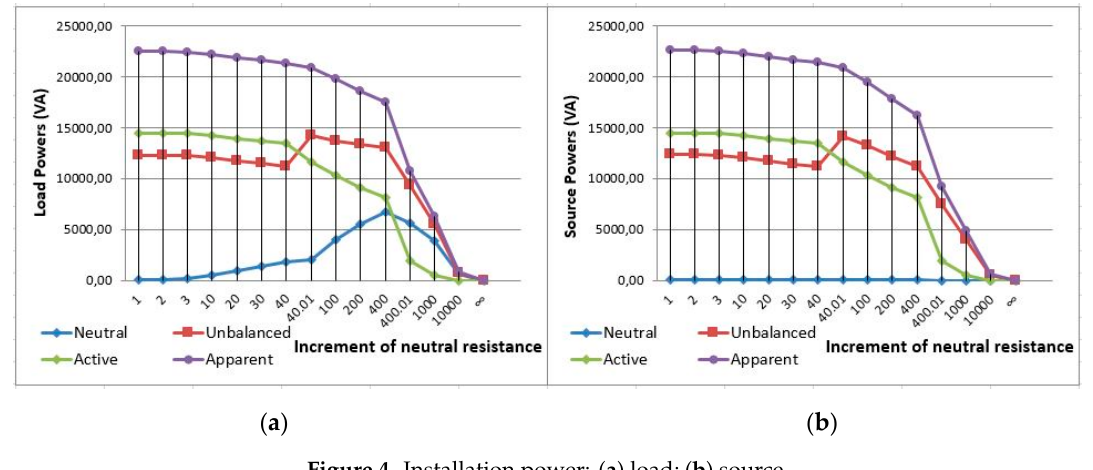
Figure 4. Installation power: ( a ) load; ( b ) source.